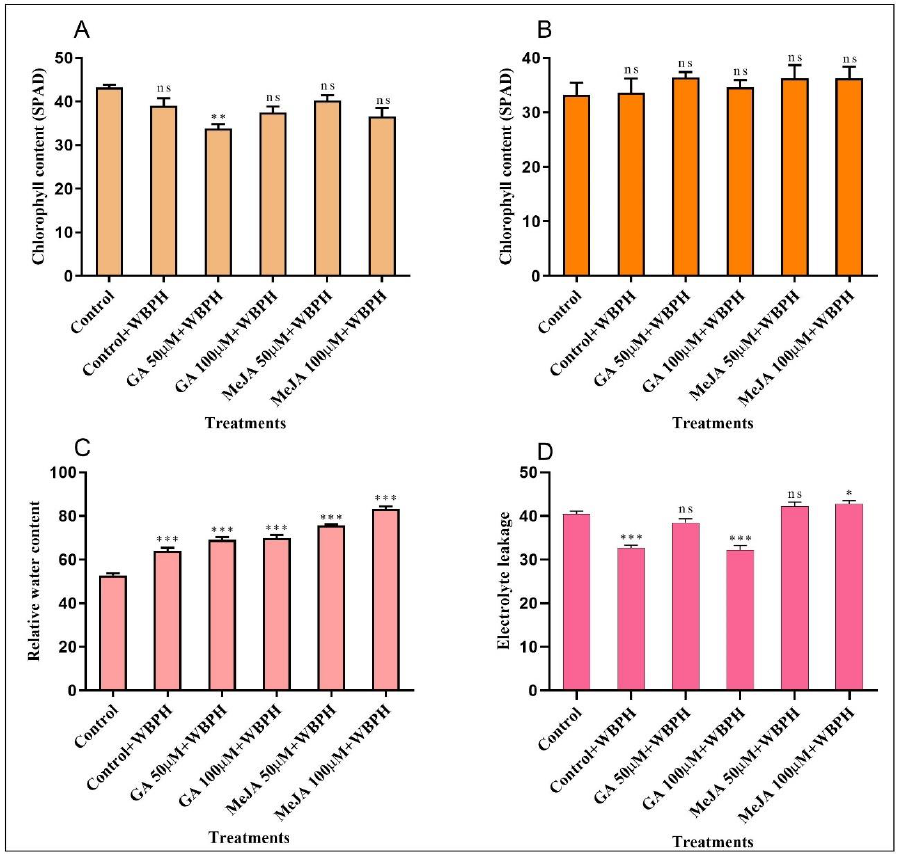
Figure 4. Measurement of chlorophyll content, RWC, and electrolyte leakage. ( A ) Chlorophyll con- tents after 10 days of WBPH inoculation and hormone treatment. ( B ) Chlorophyll contents after 30 days of WBPH inoculation and hormone treatment. ( C ) Relative water content. ( D ) Electrolyte leak- age. Each result is the mean of three replicates. Error bars represent the standard error of the mean data ( n = 3), ns represents not significant, and asterisks denote a significant difference (* p < 0.05, ** p < 0.01, *** p < 0.001), according to the analysis using two-way ANOVA and the Bonferroni post hoc test. The experiments were repeated three